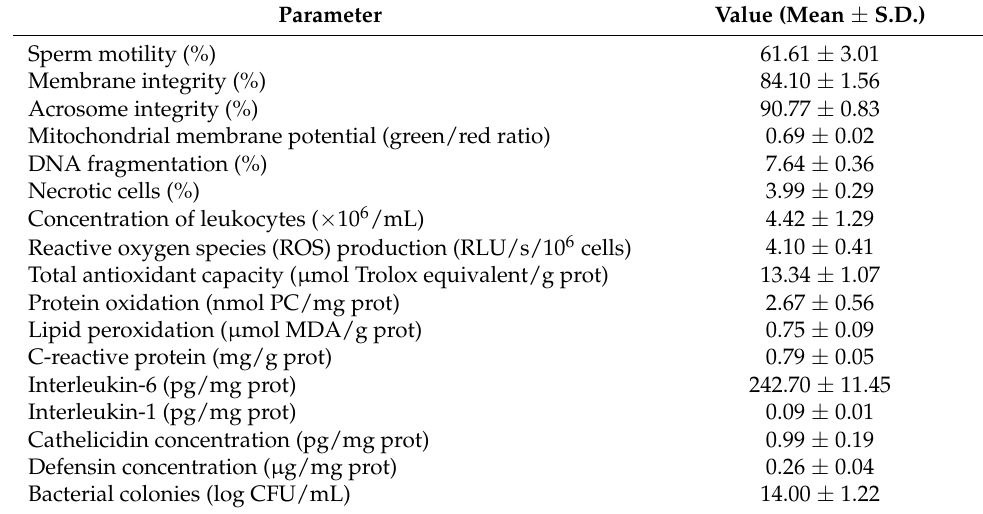
Table 2. Mean values for the qualitative parameters assessed in turkey ejaculates (n =